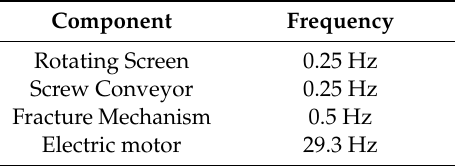
Table 7. Excitation frequencies produced by components.